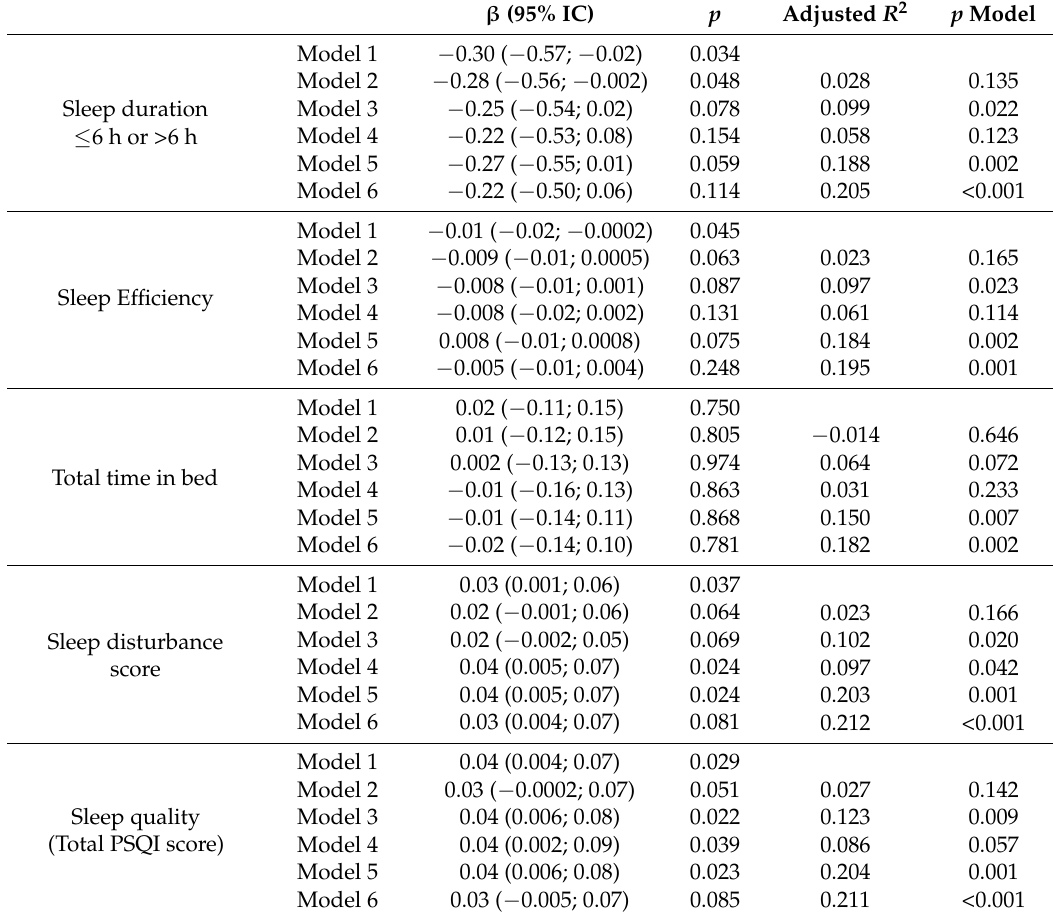
Table 4. Regression analysis of sleep characteristics and liver stiffness assessed by ARFI in patients with